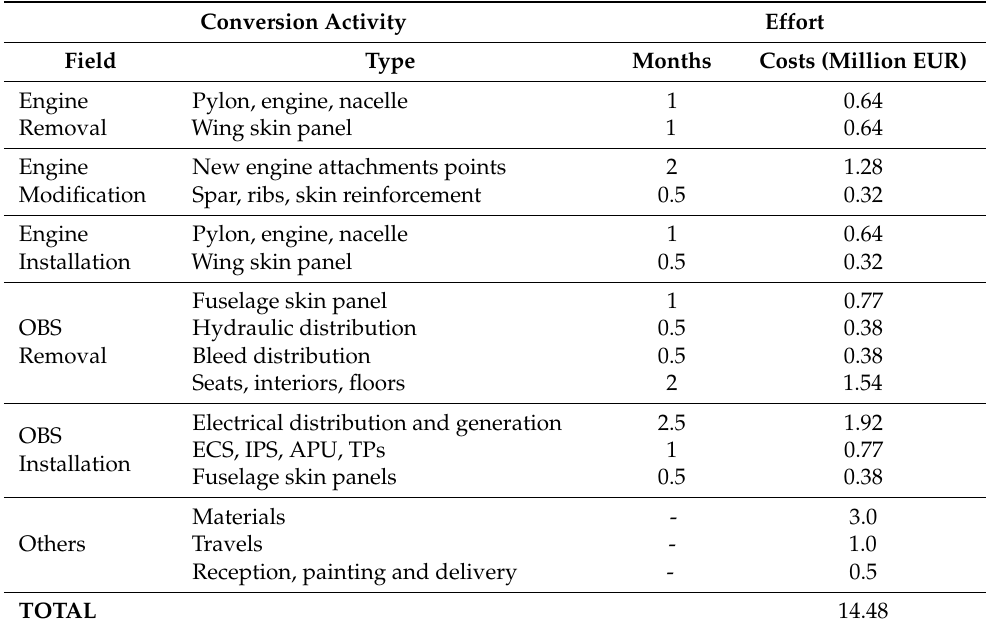
Table 8. List of the conversion activities and their related effort (in terms of the number of people, time and costs) required to perform the aircraft